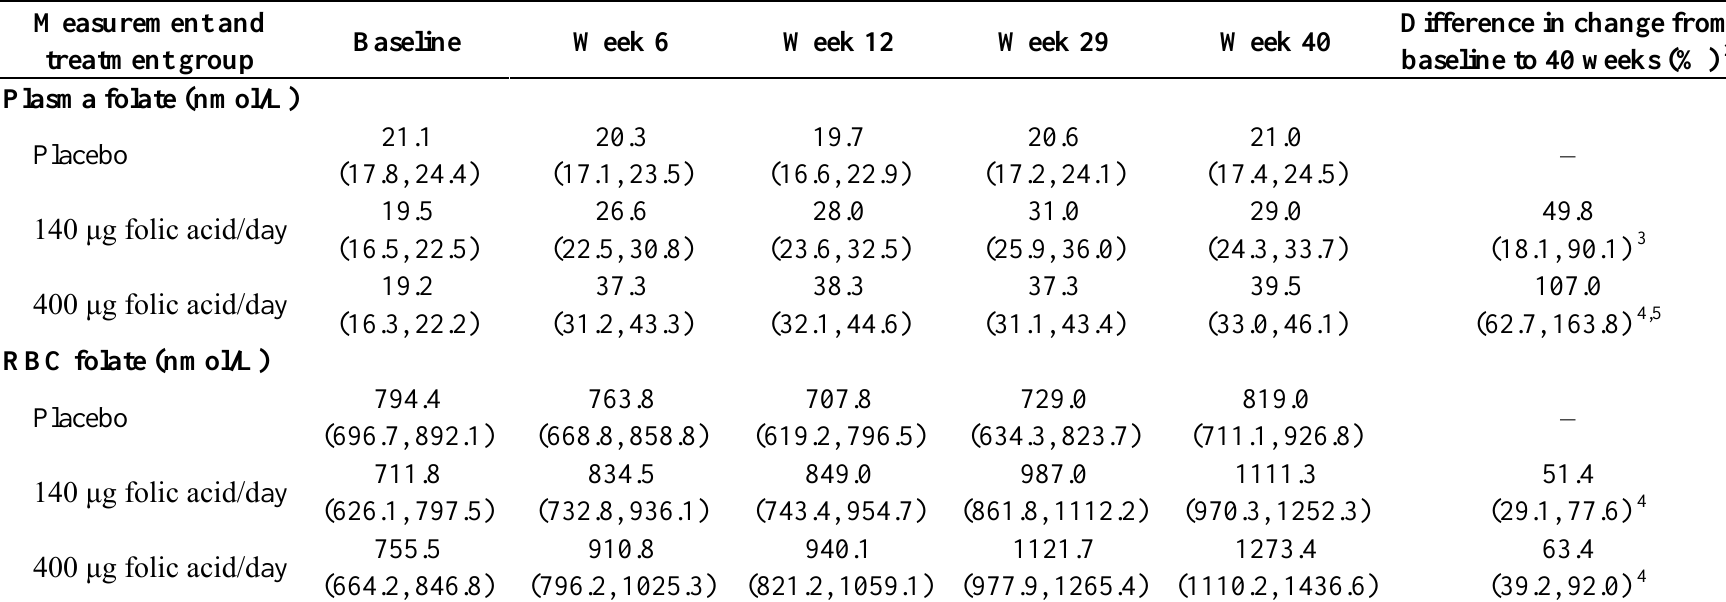
Table 2. Plasma and red blood cell folate concentrations at baseline and over the 40 week intervention period 1